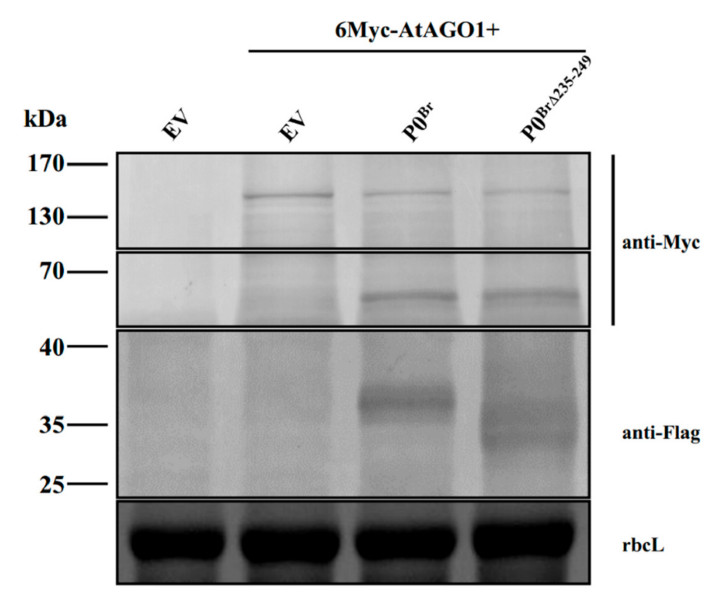
Figure 7. The P0 Br defective mutant P0 Br ∆ 235–249 had the ability to induce AGO1-degradation induction, the same as P0 Br . Analysis of the AGO1-degradation capability of P0 Br ∆ 235–249 . The 6Myc-tagged AGO1 was co-infiltrated into leaf patches of N. benthamiana with P0 Br ∆ 235–249 , P0 Br or EV. Western blotting analyses of 6Myc-tagged AGO1 and 3Flag-tagged P0 Br or P0 Br ∆ 235–249 using a Myc monoclonal antibody (anti-myc) and a Flag monoclonal antibody (anti-Flag), respectively. Stained rubisco is shown to indicate equal lane